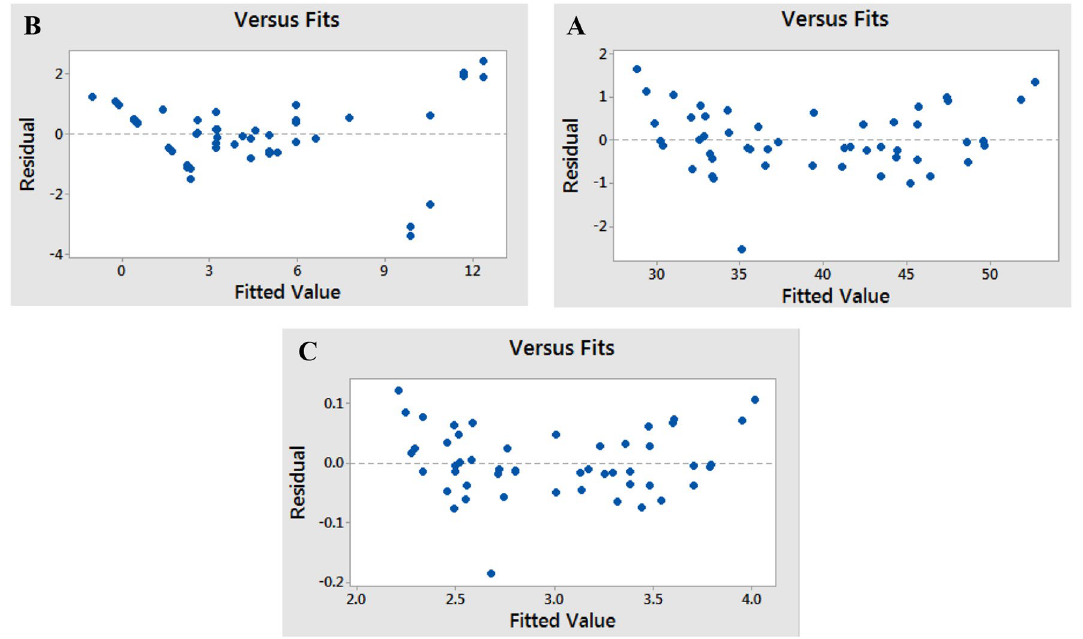
Fig. 4 Residue diagram status for three target functions a cumulative oil production, b cumulative water production, c net present